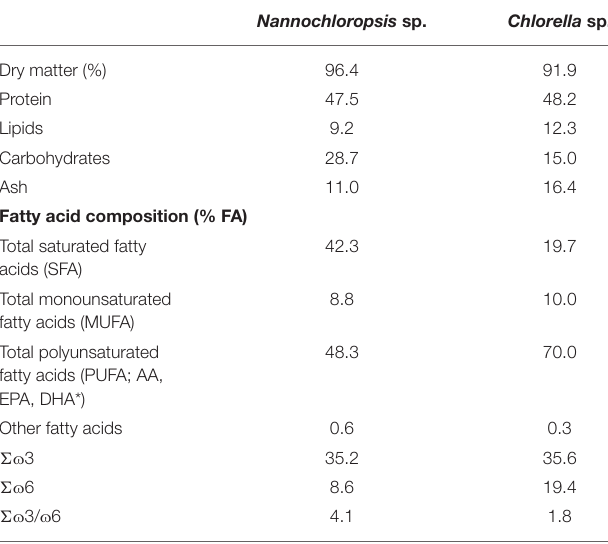
TABLE 1 | Proximate composition (% dry matter) of